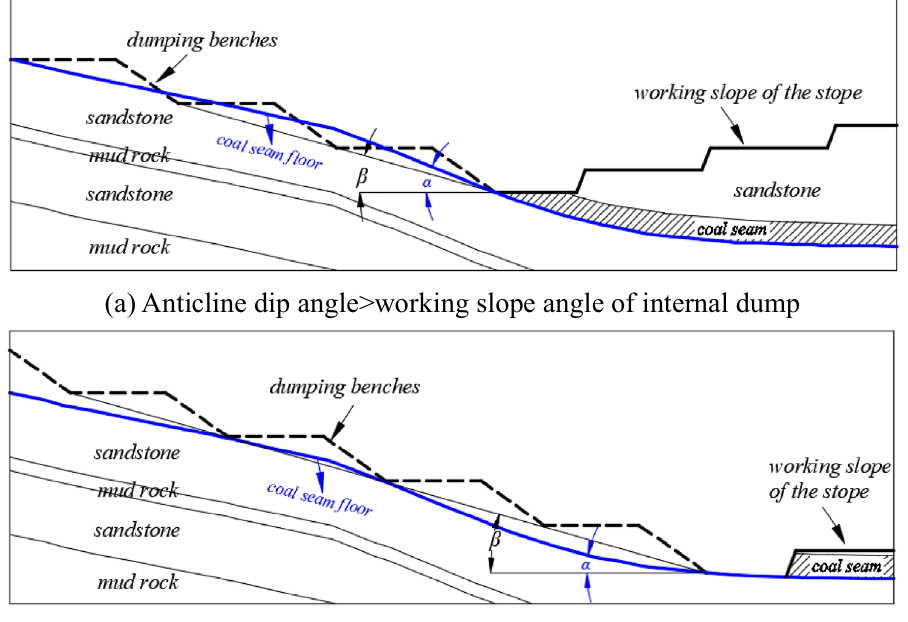
Fig. 2 Diagram of internal dump construction conditions in anticline region